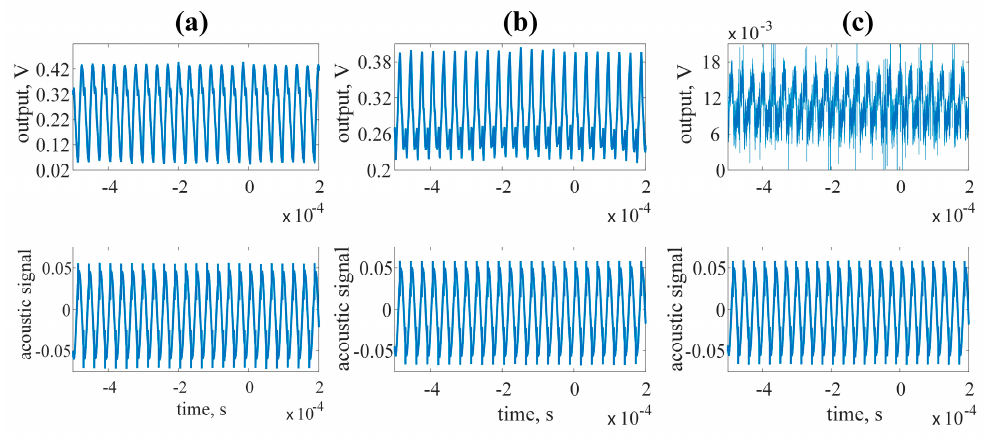
Figure 10. Output signals observed at the output the investigated preamplifier working in different